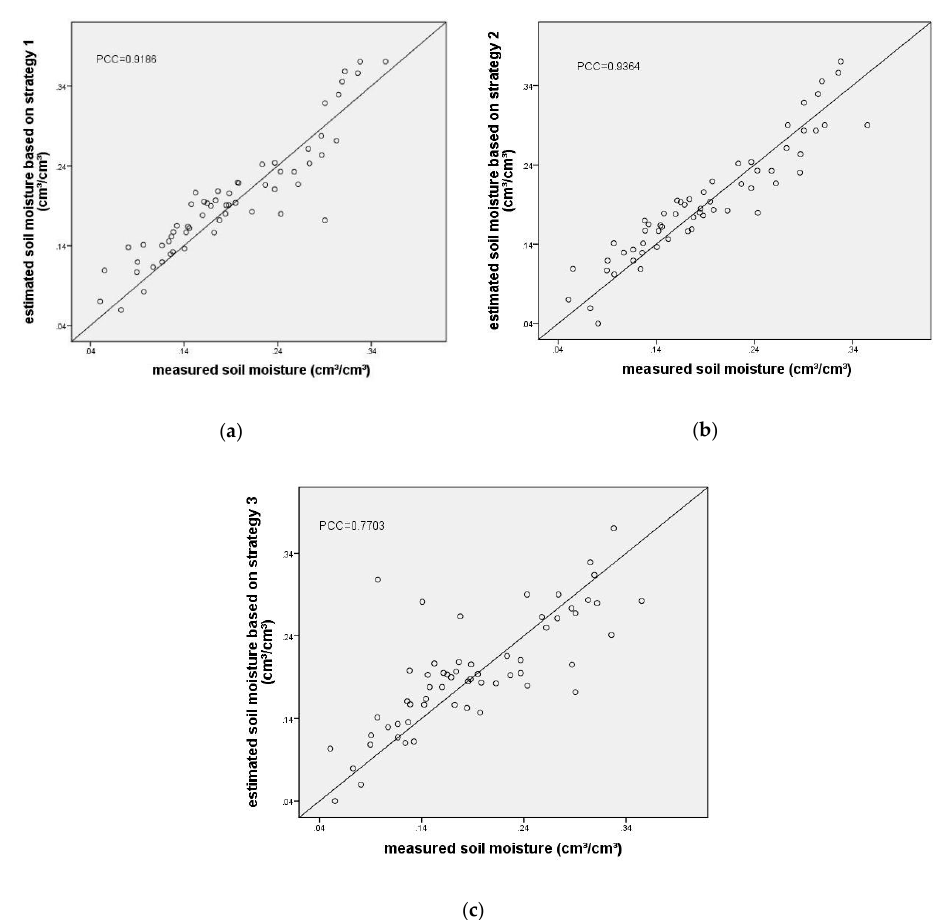
Figure 11. Scatter plots between the measured and estimated soil moisture values obtained using the optimal solution methods based on the 60 in situ experimental datasets. A 1:1 line is included in this plot. ( a ) strategy 1; ( b ) strategy 2; ( c ) strategy 3.